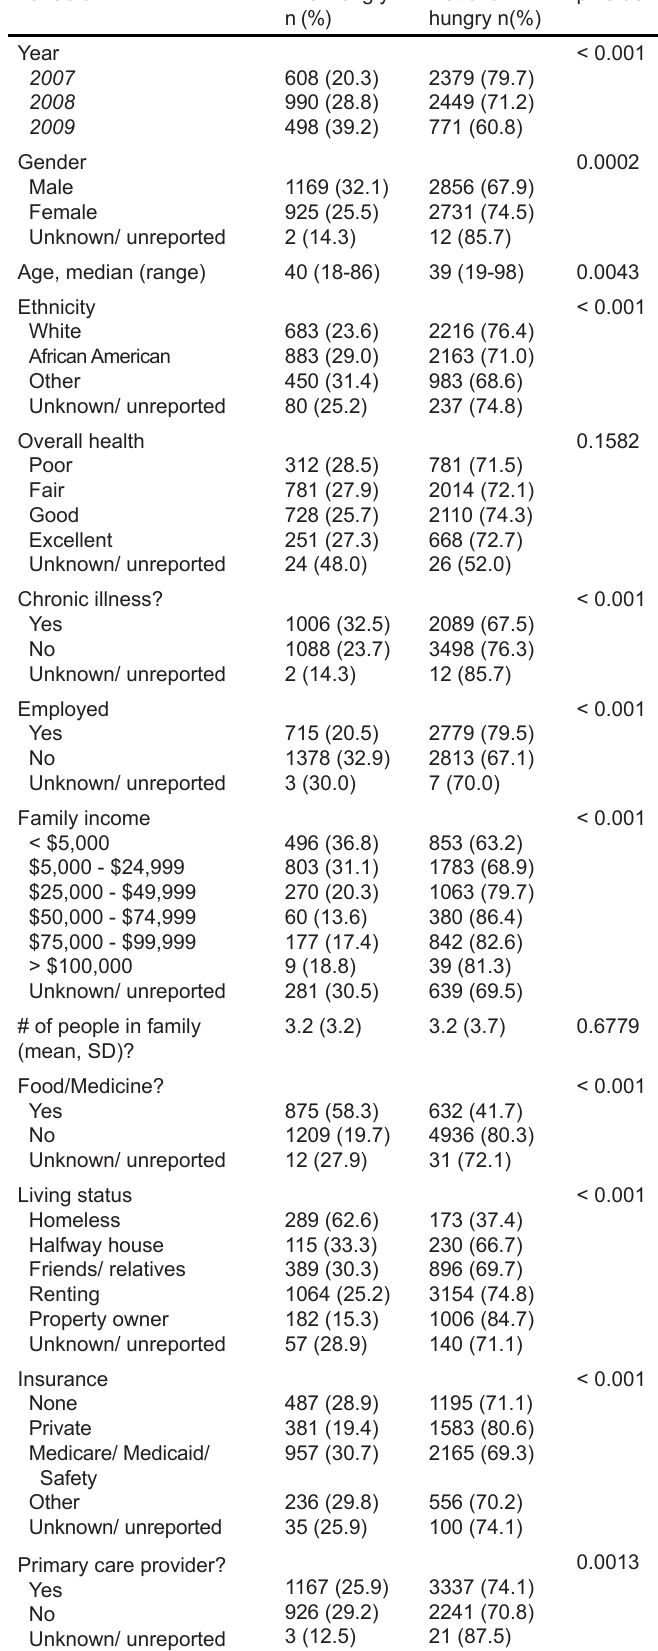
Table 4. Demographics by hunger